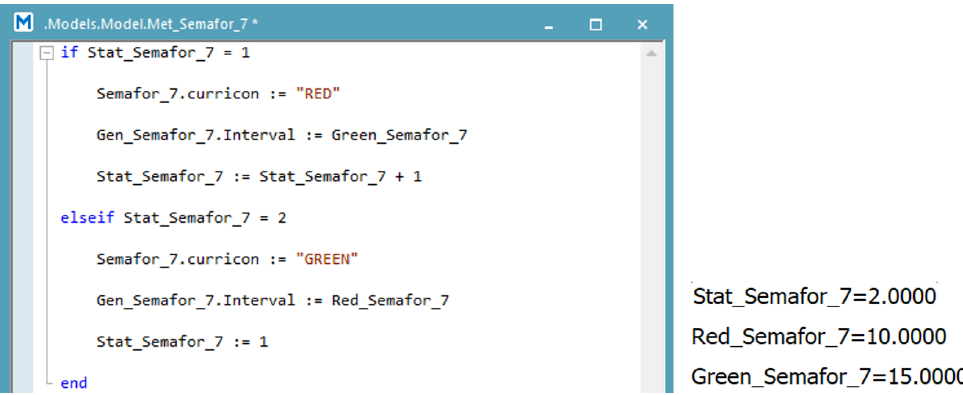
Figure 9. Method of road light signaling for pedestrians and defining TLS variables for pedestrians.